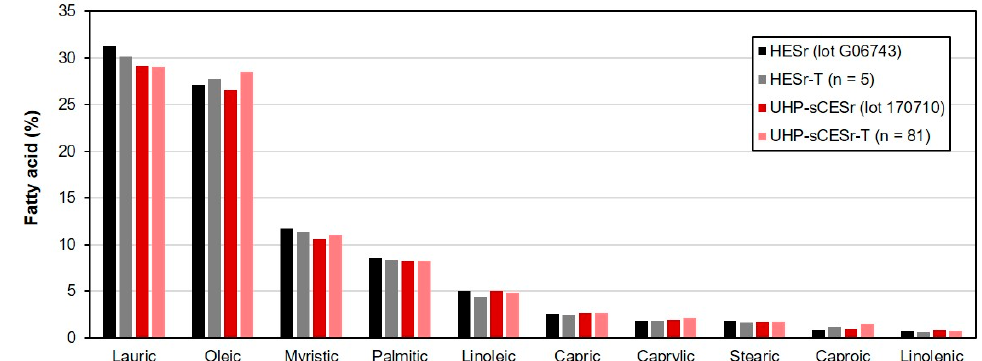
Figure 3. Individual fatty acid content ( w / w ) for the hexanic extract of Serenoa repens (HESr; lot G06743), HESr typical data (HESr-T; n = 5), an ultrahigh-pressure supercritical carbon dioxide extract of S. repens (UHP-sCESr; lot 170710), and UHP-sCESr typical data (UHP-sCESr-T; n = 81). The lauric acid ratios (lauric acid %: individual fatty acid %) for each fatty acid were also similar for HESr (lot G06743), HESr-T (n = 5), UHP-sCESr (lot 170710), and UHP-sCESr-T (n = 81) (Table